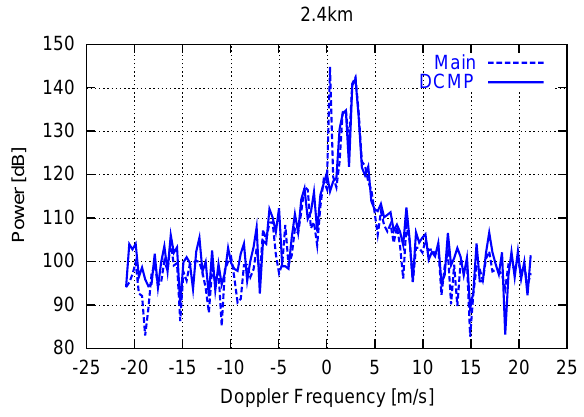
Fig. 4. Doppler echo power spectrum at 2.4km range raw main beam data (dashed) and processed with conventional DCMP algo- rithm (solid). The y-axis indicates received power in arbitrary units.